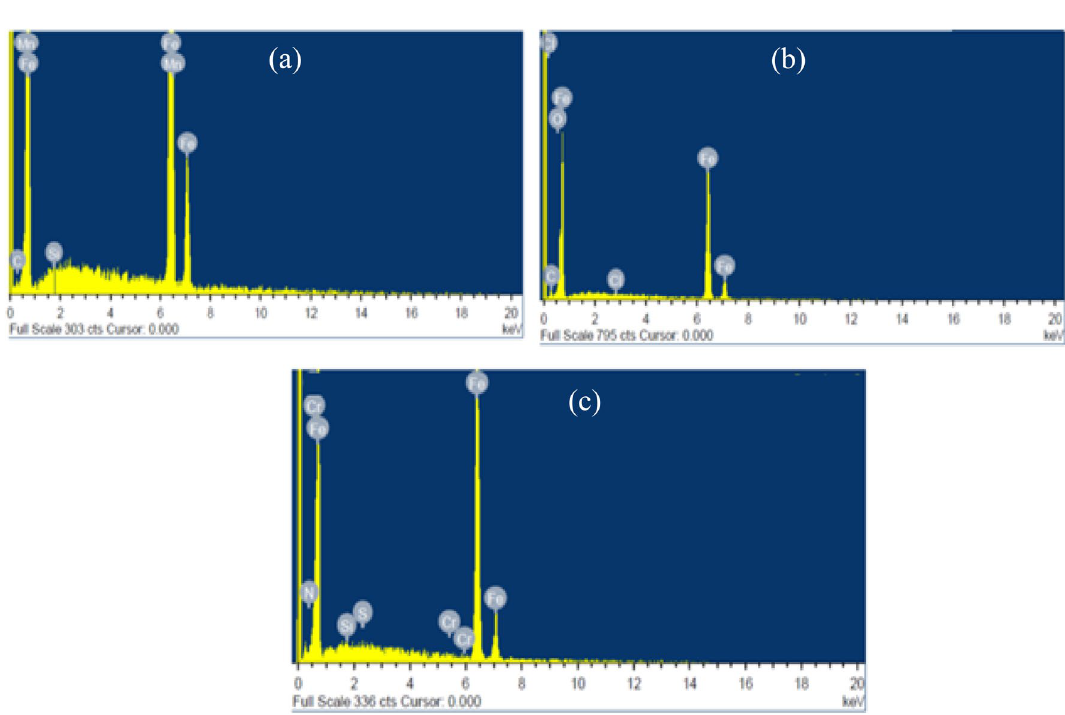
Figure 10. EDS photographs of MS surface immersed in 5% HCl with ( a ) absence of inhibitor ( b ) existence of